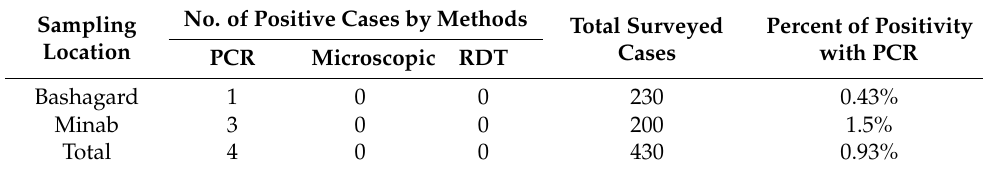
Table 2. Positive cases according to sampling location among local residents in an asymptomatic malaria